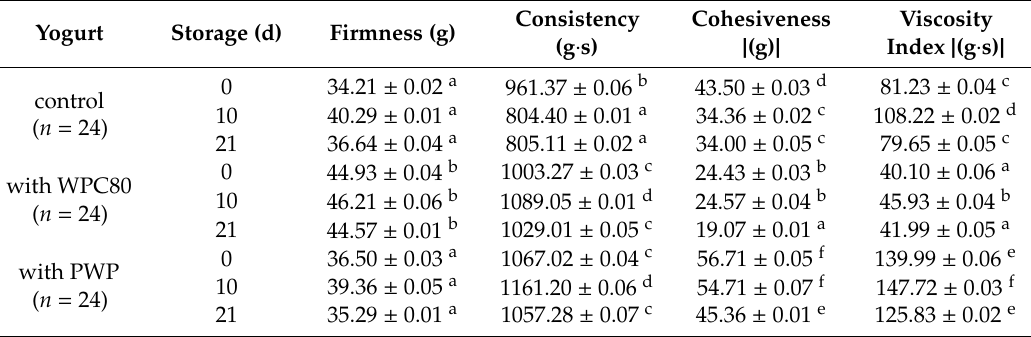
Table 4. Texture parameters of yogurt with increased whey proteins content, including whey proteins after the polymerization process.